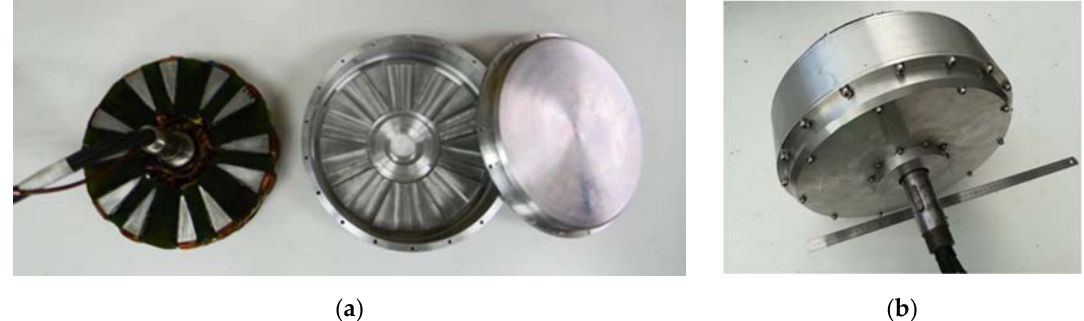
Figure 16. ( a ) Stator and the two motor covers, showing in the central part the SMC rotor pieces glued